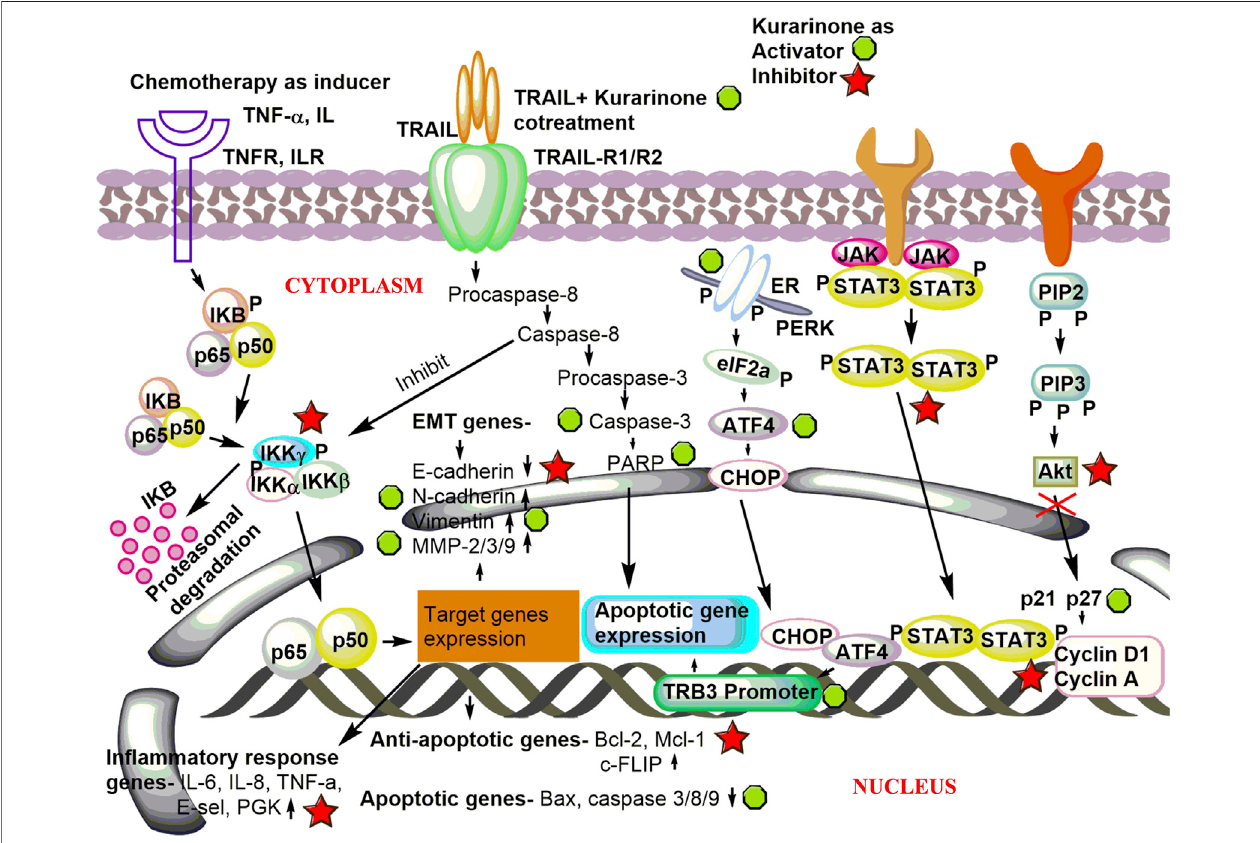
FIGURE 3 | Underlying anticancer mechanism of kurarinone. Kurarinone induces apoptosis and cytostatic effects in cancer cells and inhibits invasion, metastasis, and cellular proliferation. TNF- α , tumor necrosis factor- α ; TNFR, tumor necrosis factor receptor; IL, interleukin; ILR, interleukin receptor; TRAIL, TNF-related apoptosis inducing ligand; TRAIL-R1/R2, TNF-related apoptosis inducing ligand-receptor 1/2; EMT, epithelial mesenchymal transition; MMP, matrix metalloproteinase; PGK, phosphoglyceratekinase;cellularFLICE(FADD-likeIL-1 β -converting enzyme),inhibitoryprotein; Mcl-1,myeloidleukemiaandchlamydia;PARP,poly(ADP-ribose) polymerase; ER, endoplasmic reticulum; PERK, protein kinase R (PRK) like endoplasmic reticulum; eIF2a, eukaryotic translation initiation factor 2A; ATF4, activating transcriptional factor 4; C/EBP, homologous protein; TRB3, Tribbles homolog 3; JAK-STAT, Janus kinase-signal transducer and activator of transcription; PIP2, phosphatidylinositol 4,5-bisphosphate; PIP3, phosphatidylinositol (3,4,5)-trisphosphate; Akt, protein kinase